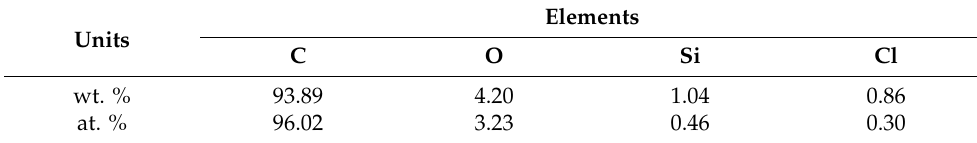
Table 2. The atomic and weight percent of the elemental composition of the SiC ‐ AC adsorbent. Units wt. %